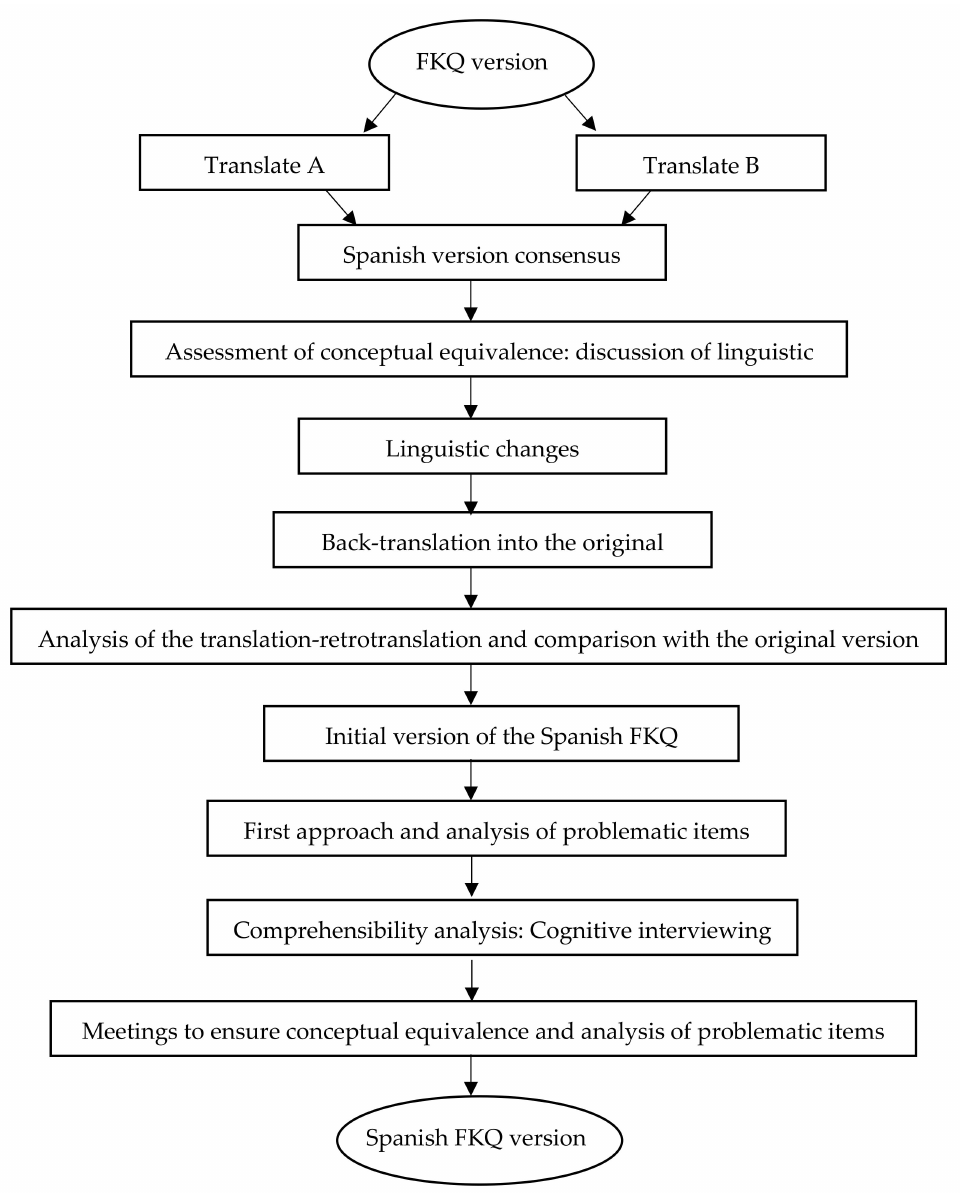
Figure 1. Translation and cultural adaptation procedure of the Spanish version of the Fibromyalgia Knowledge Questionnaire